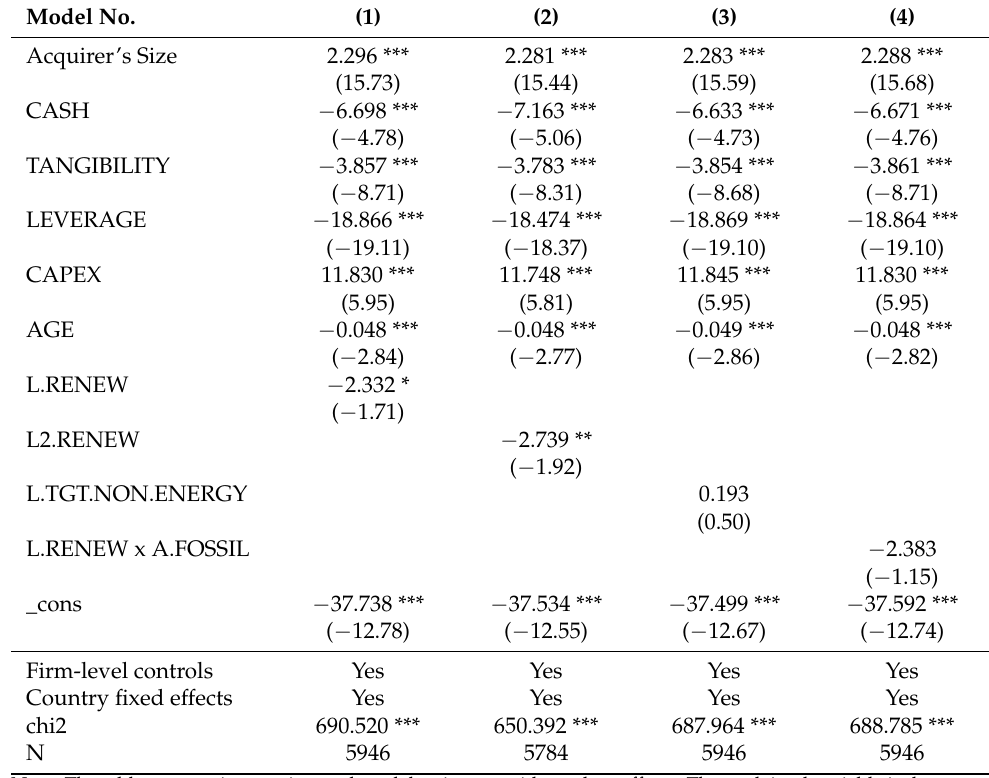
Table 9. Acquisitions of renewable energy companies and acquirers’ post-deal operating performance. Model